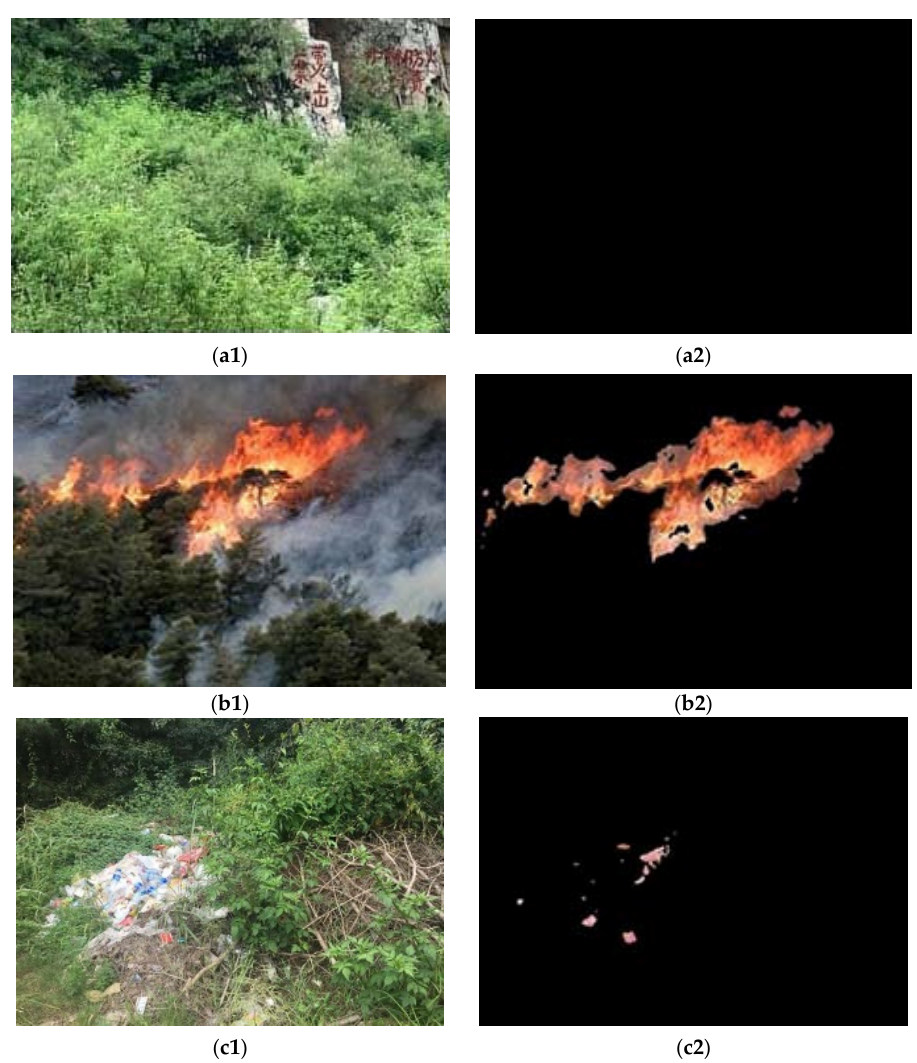
Figure 4. Extraction results via RGB color space: ( a1 ) Forest image without fire; ( a2 ) extraction results of a forest image without fire; ( b1 ) forest image with fire; ( b2 ) extraction results of forest image with fire; ( c1 ) forest image with fire-like interference; ( c2 ) extraction results of forest image with fire-like interference.